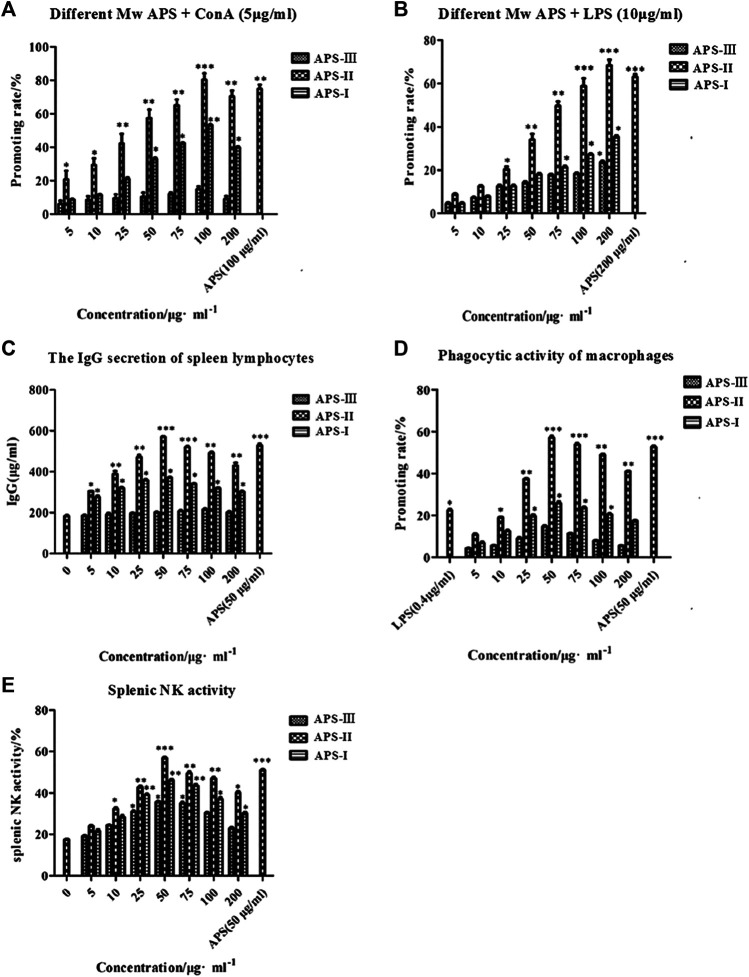
Immune-potentiating of APS on the mouse lymphocytes with ConA (A), the immune-potentiating of APS on the mouse lymphocytes with LPS (B), the effects of polysaccharides on the IgG secretion of spleen lymphocytes (C), the functions of APS on the phagocytic activity of peritoneal macrophages (D), the effects of APS on splenic NK activity (E), *p < 0.05, **p < 0.01, ***p < 0.001 vs. the positive control. n = 6, x ± s.